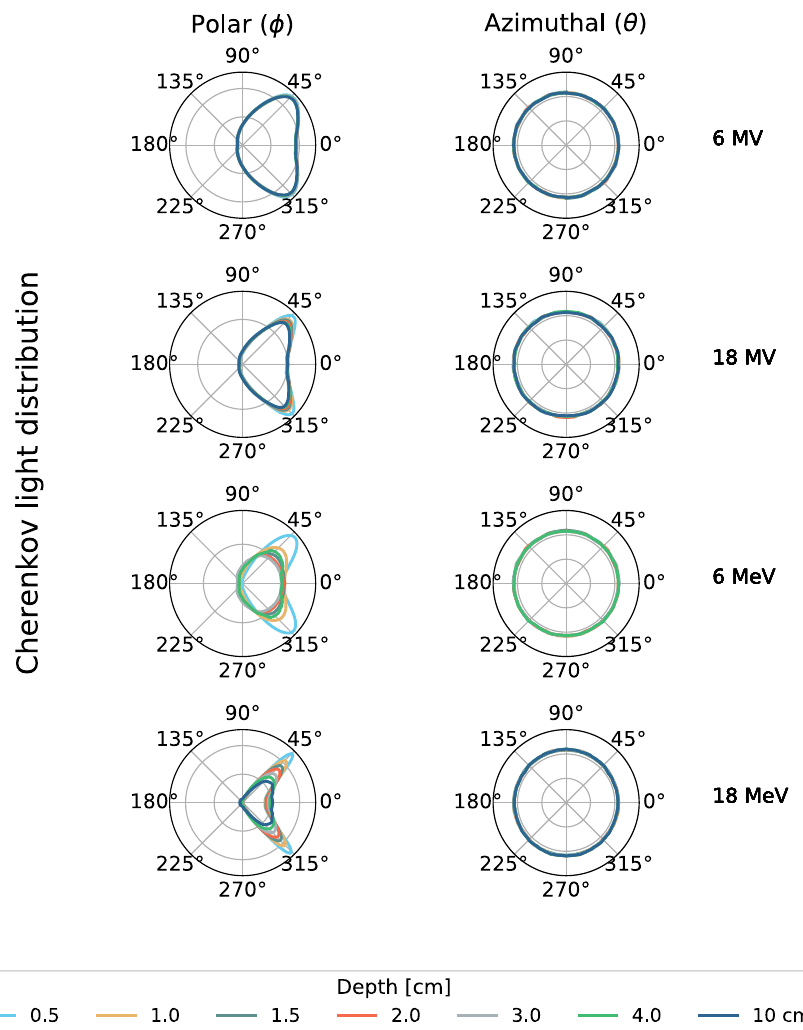
Figure 1. Cherenkov signal polar and azimuthal distributions extracted from different depths along the beam central axis using Monte Carlo simulations. The distributions were acquired for 6 MV , 18 MV , 6 MeV and 18 MeV beams. Data at 10 cm depth was not extracted for the 6 MeV beam because too little dose reaches that